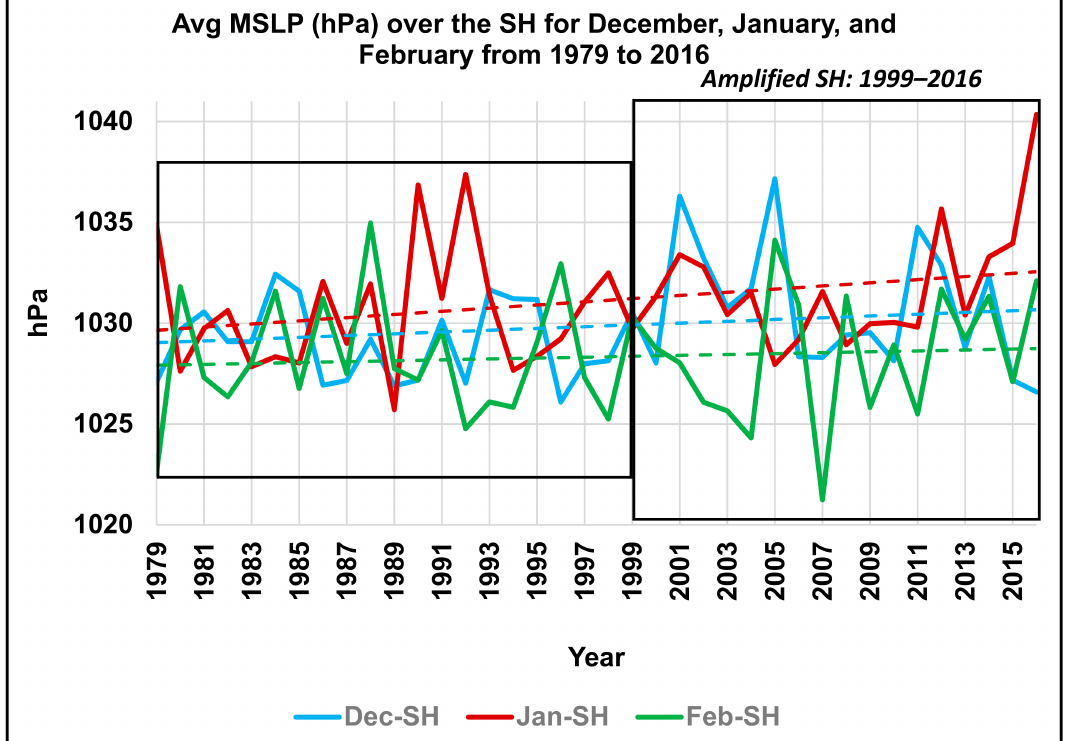
Figure 1. Average MSLP (hPa) over the Siberian High (SH) domain defined between 40 ◦ N–60 ◦ N and 80 ◦ E–120 ◦ E for December, January, and February from 1979–2016 as computed from the European Centre for Medium Range Weather Forecast (ECMWF), ERA-Interim. Dotted lines indicate fitted linear trends for December (blue color), January (red color), and February (green color) with only January showing a noticeable trend with a p -value of 0.06 from Mann–Kendall